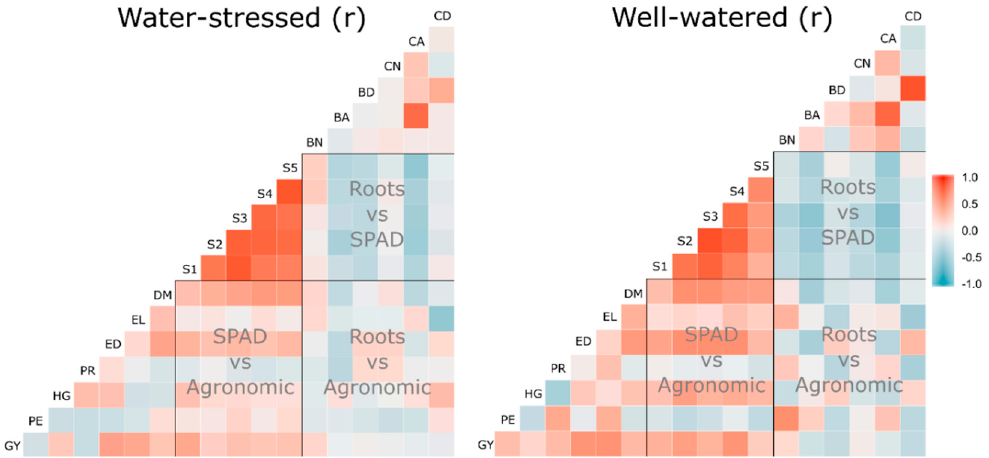
Figure 2. Phenotypical correlation among 18 traits evaluated in 20 popcorn inbred lines under two different water conditions. Agronomic traits—GY: grain yield; PE: popping expansion;